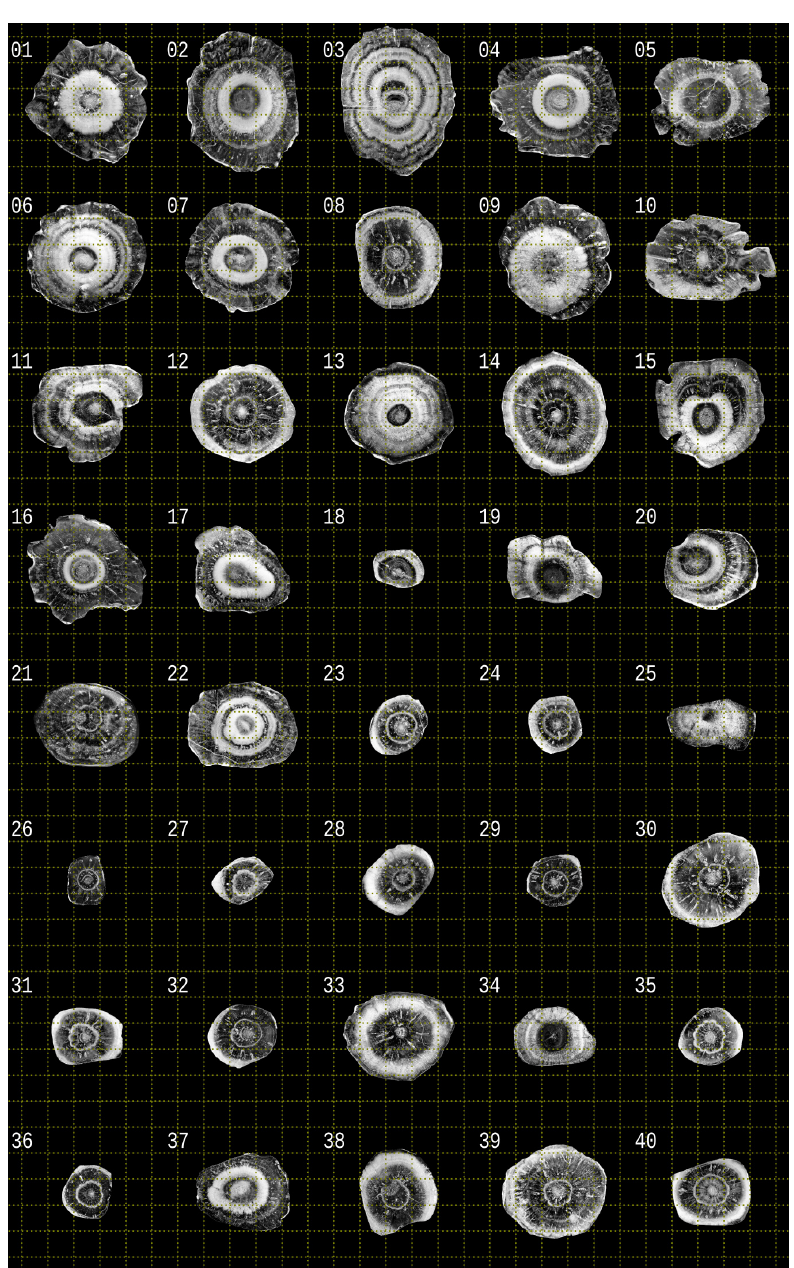
Figure 5. Hailstone cross sections from the Melbourne hailstorm event (19 January 2020). Grid lines shown at a 1cm